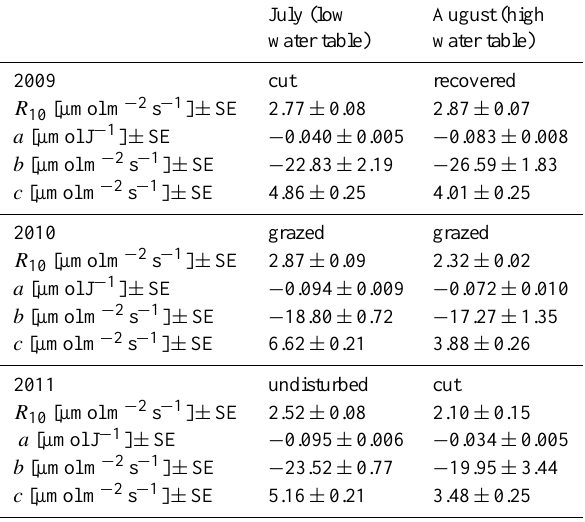
Table 5. Results from the curve fitting of nighttime net CO 2 fluxes against soil temperature and daytime net CO 2 fluxes against incom- ing solar radiation. R 10 refers to Eq. (2) and a , b and c refer to Eq. (3). July